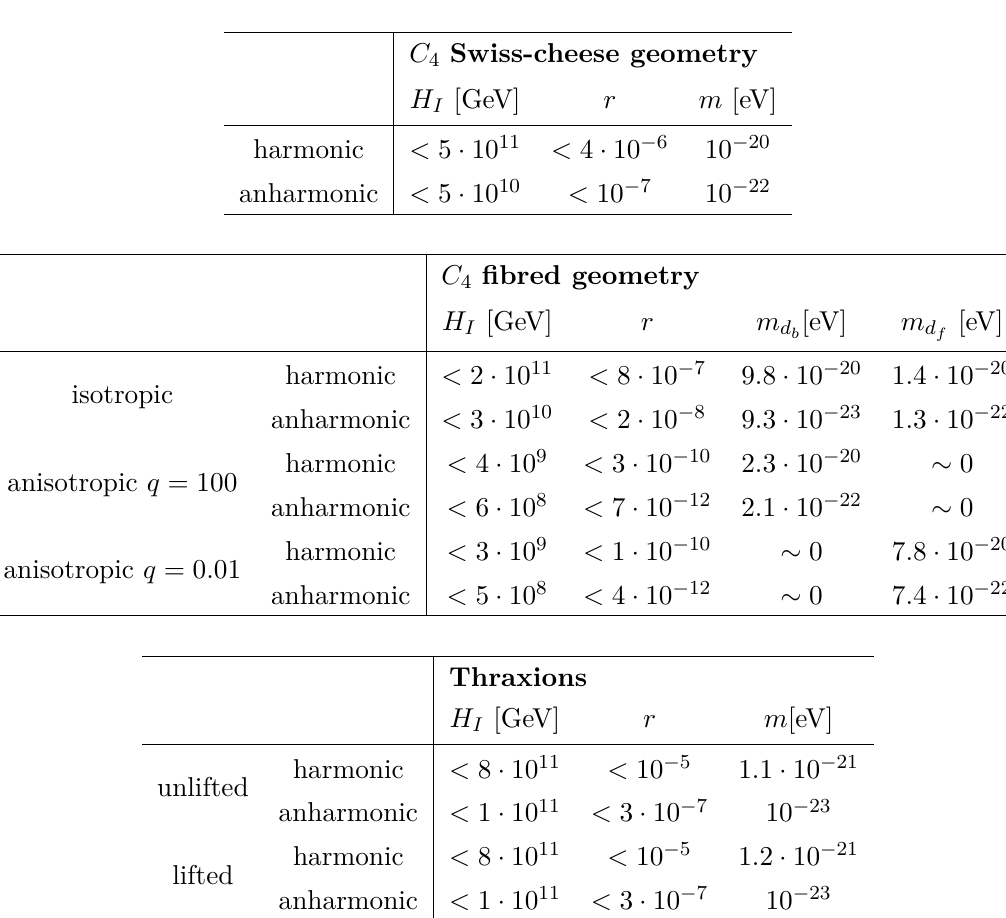
Table 5 . Boundaries on the inflationary scale H I and the tensor-to-scalar ratio r coming from isocurvature perturbations constraint. We consider both the harmonic approximation (quadratic potential) that is valid for small misalignment angles and the full anharmonic setup (cosine poten- tial) where the θ is tuned to θ = 0 . 99 π . Top: C FDM from CY Swiss-cheese geometry. We mi mi 4 fix W = 1 , A = 1 and a = 1 . Center: C FDM from CY fibred geometry. We fix A 0 s s 4 √ and W = 1 . We consider both isotropic, q = f = 2 , and anisotropic compactification 0 d b /f d f q = 100 , 0 . 01 . Bottom: Thraxion FDM considering both the stabilisation in absence (unlifted) and in presence (lifted) of moduli